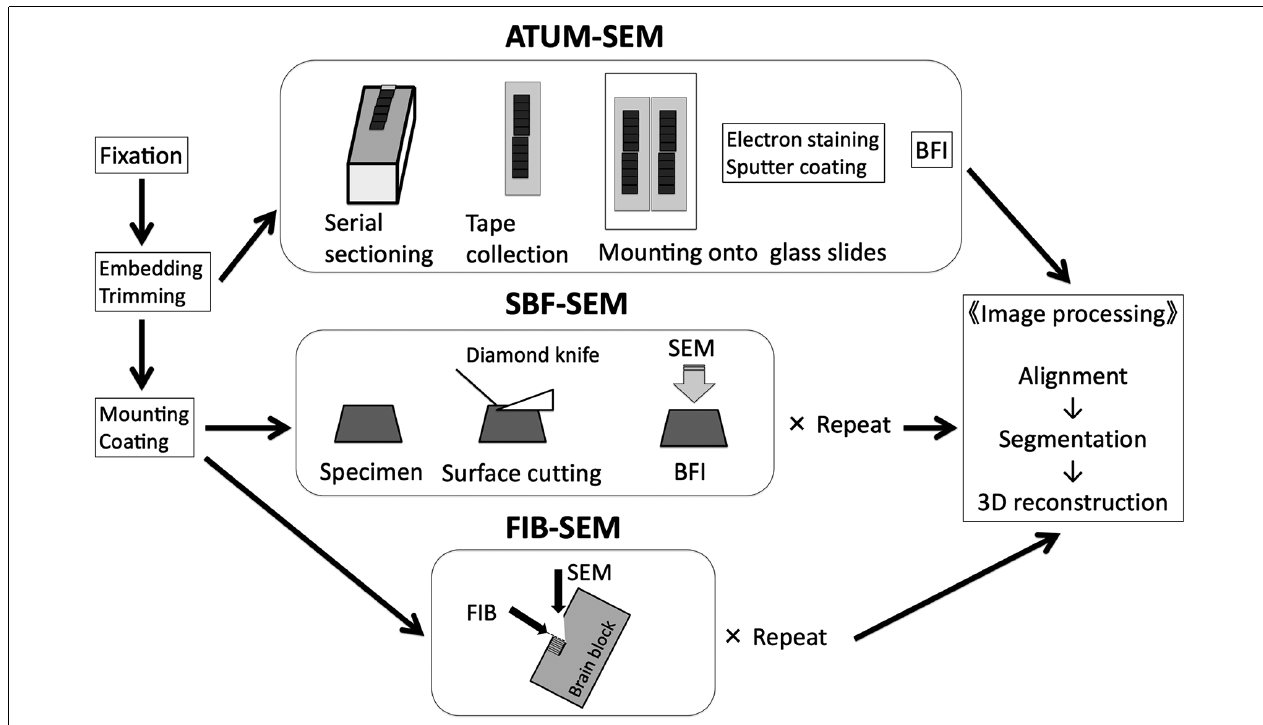
FIGURE 1 | Basic workflow of three different SEM-based volume imaging methods. ATUM-SEM, automated tape collecting ultramicrotome scanning electron microscopy; BFI, block-face imaging; FIB-SEM, focused ion beam scanning electron microscopy; SBF-SEM, serial block-face scanning electron microscopy. Modified from Koike (2018) with permission. In our lab, we use FIB-SEM to typically image a cube of 10 µ m × 10 µ m × 10 µ m for three-dimensional reconstruction of dendritic shafts and